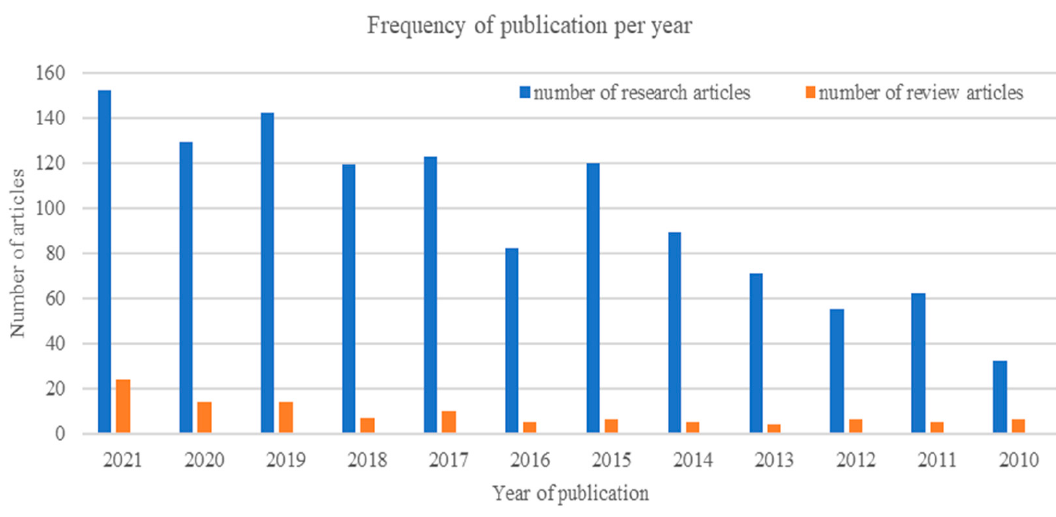
Figure 2. The annual rating of research and review articles on BCI rehabilitation devices.